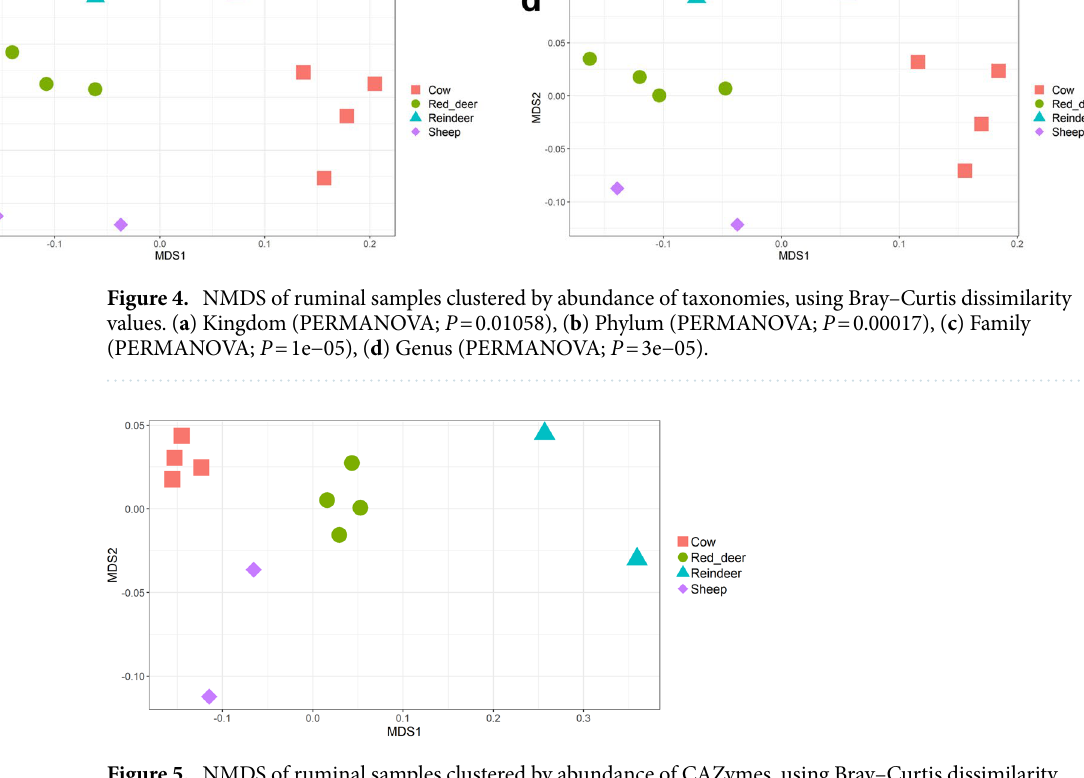
Figure 5. NMDS of ruminal samples clustered by abundance of CAZymes, using Bray–Curtis dissimilarity values (PERMANOVA; P =